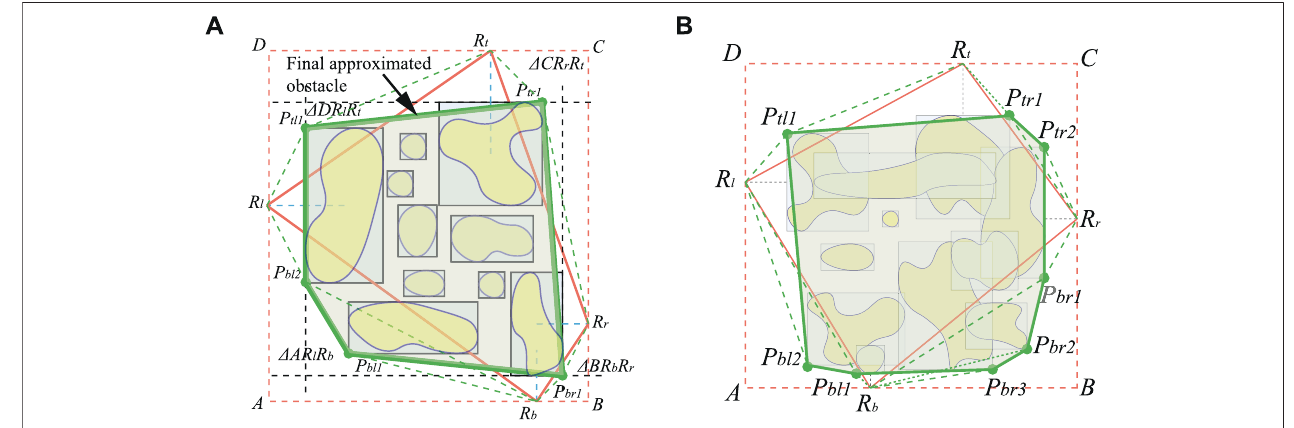
FIGURE 5 | The illustration of obstacle fusion. (A) The fi nal obstacle fusion for a set of non-overlapping obstacles. (B) The obstacle fusion for a set of overlapping obstacles\enleadertwodots.